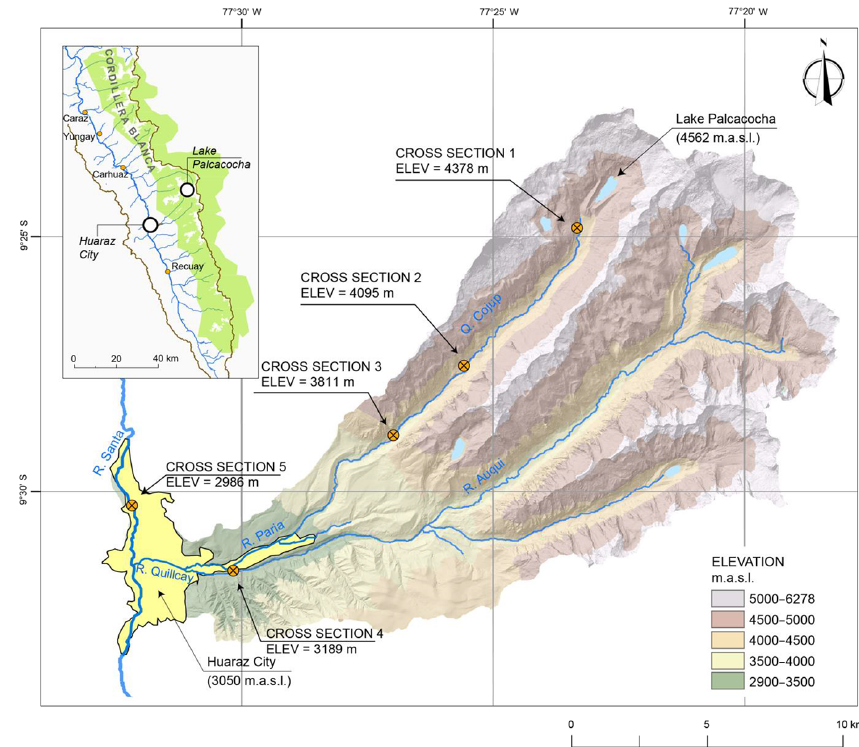
Figure 1. Map of the study area showing Lake Palcacocha and the city of Huaraz in the Quillcay watershed and the digital elevation model (DEM) of the Quillcay watershed. The locations where hydrographs of the FLO2D simulation results are illustrated are marked as cross